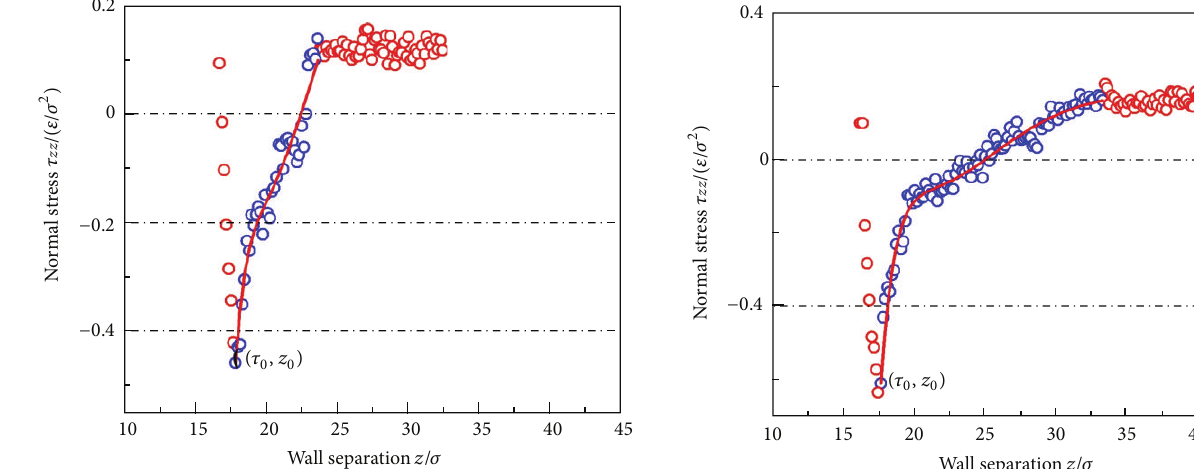
Figure 41: The nonlinear square fit of normal stress data using (19) for functional PFPE ( 𝜀 𝑝 𝑏 = 𝜀 𝑝 𝑤 = 3𝜀 )